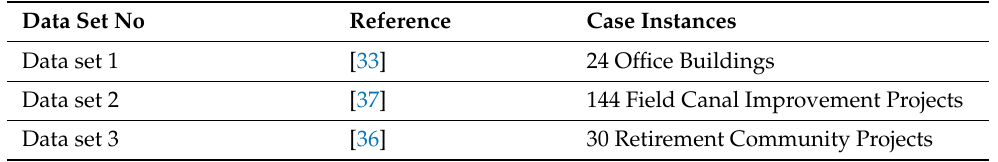
Table 1. Test Cases.